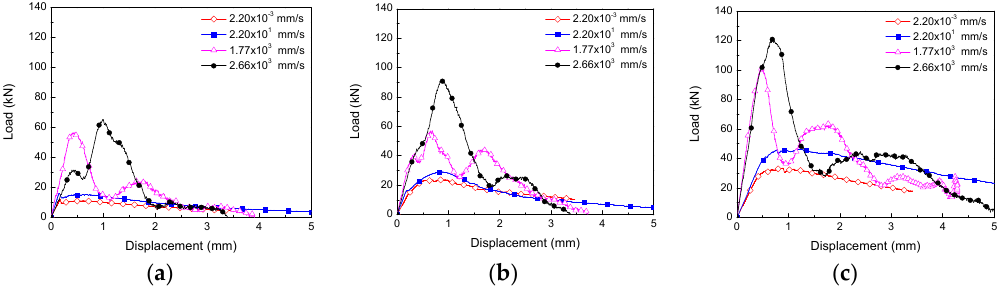
Figure 7. Load-displacement curves at different loading rates. ( a ) Concrete PA; ( b ) Concrete PB; ( c ) Concrete PC.